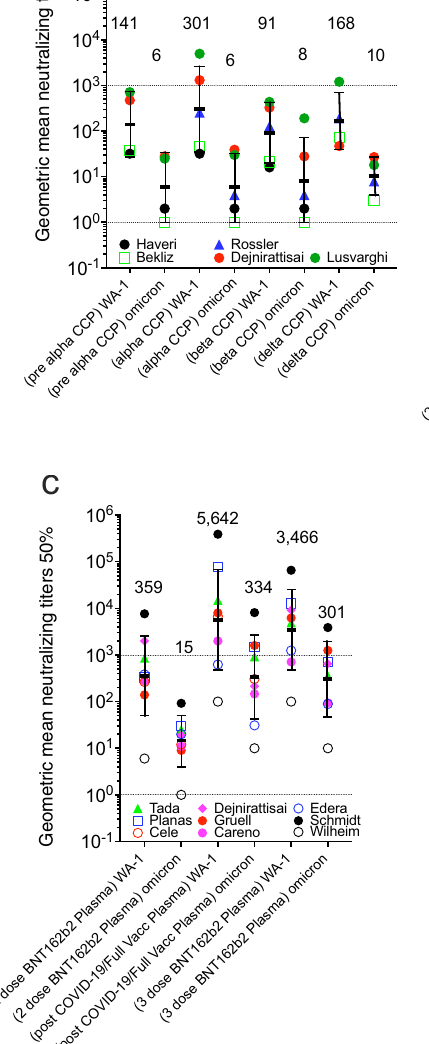
Fig. 4 | Geometric mean neutralizing titers (GMT 50 ) of anti-WA.1 or anti- Omicron BA.1 neutralizing antibodies in plasma samples from 5 studies investigating diverse SARS-CoV-2 infecting lineage or vaccination status. Five studiescharacterized a pre-Alpha,Alpha,Beta,andDeltaCCPforOmicronBA.1nAb comparedtoWA-1,andalso b 2or3dosesBNT162bplasma,aswellaspost-COVID-